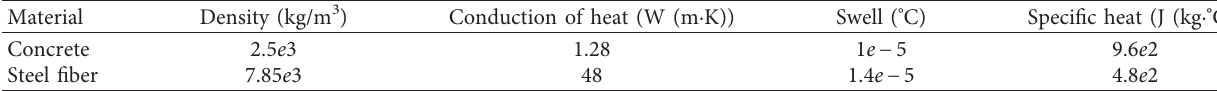
Table 5: Thermodynamic parameters.